Question: Express in one sentence what the figure is showing.
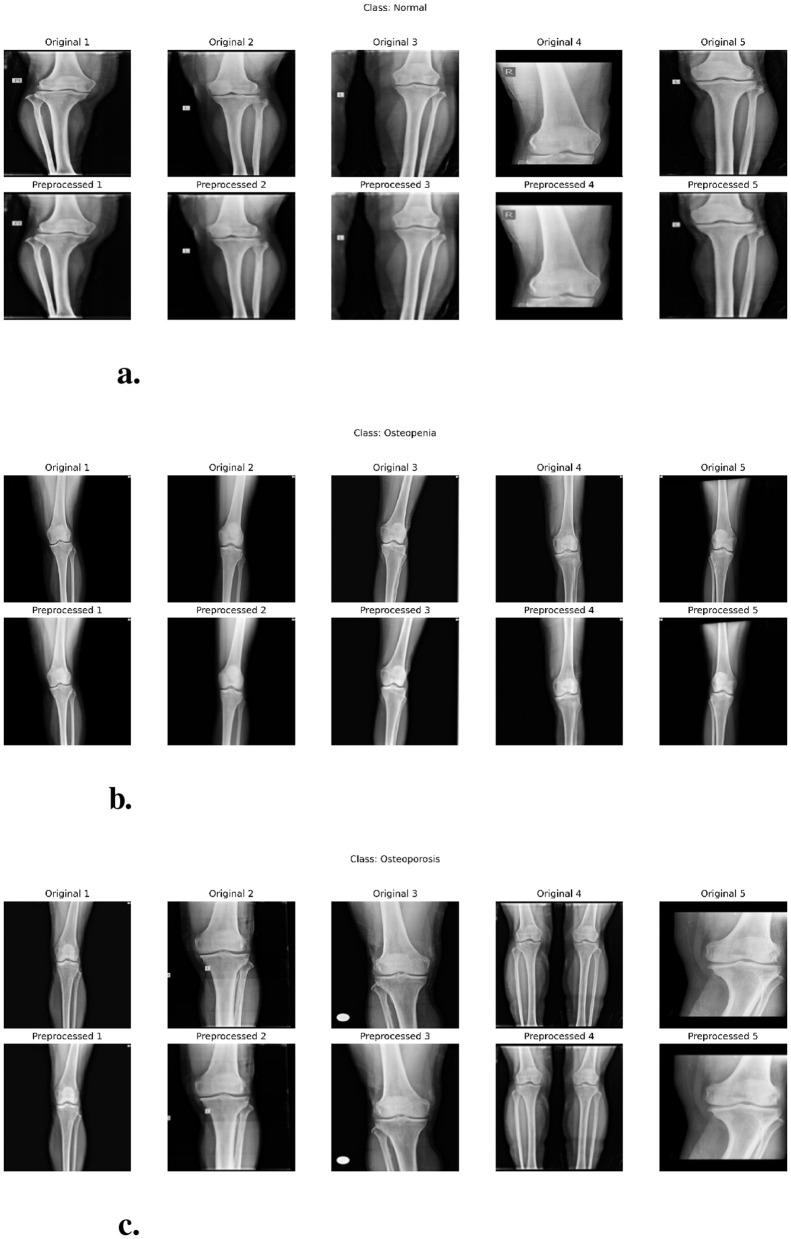
Answer: Preprocessing of X-ray images across different conditions. (a) Preprocessing using normal X-ray images using Multi-Class Knee Osteoporosis X-ray Dataset. (b) Preprocessing using Osteopenia X-ray images using Multi-Class Knee Osteoporosis X-ray Dataset. (c) Preprocessing using Osteoporosis X-ray images using Multi-Class Knee Osteoporosis X-ray Dataset.